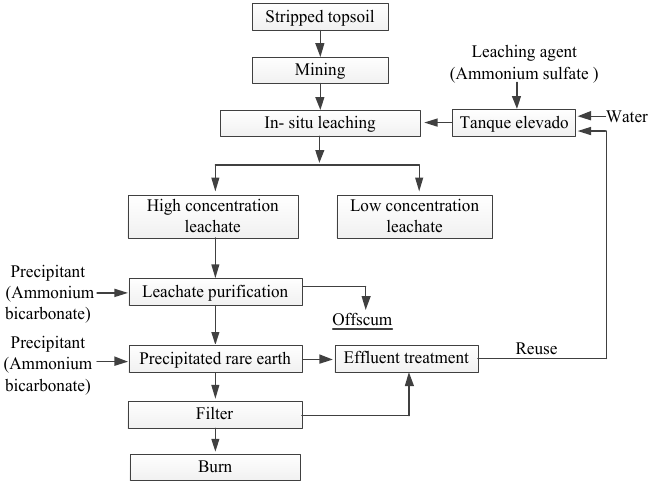
Figure 7. Third generation leaching extraction process.